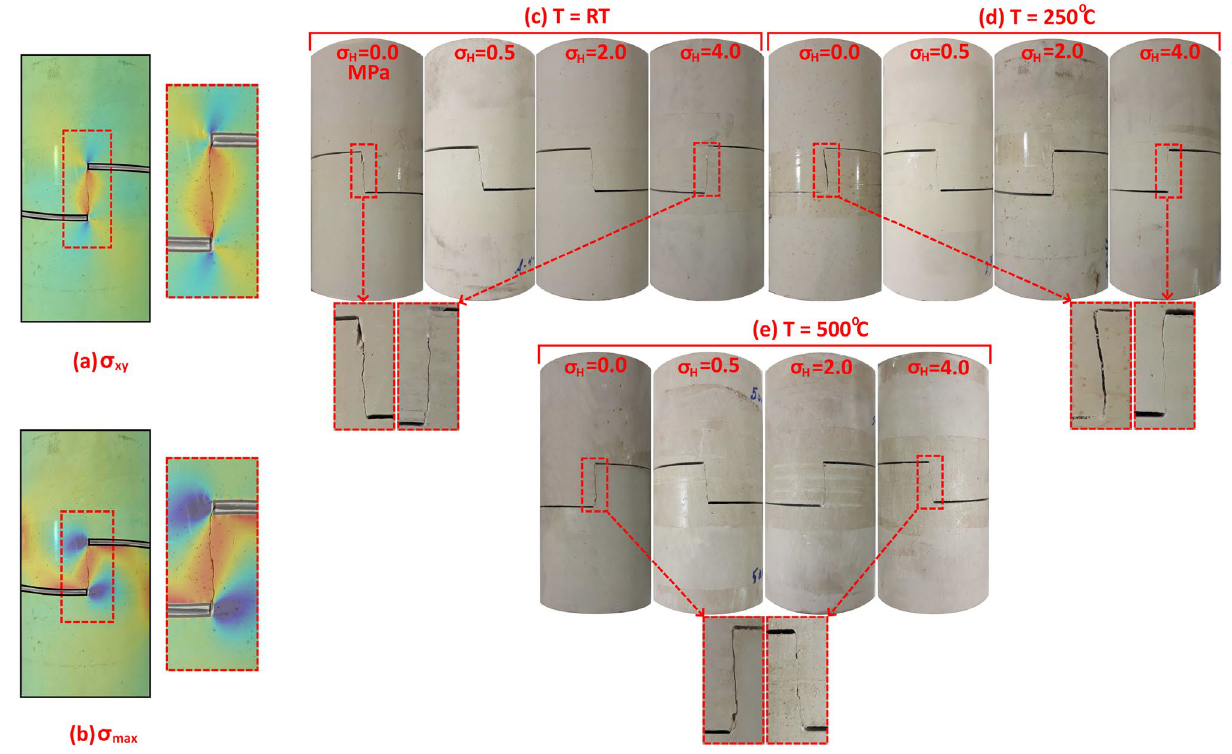
Figure 11. Comparison between numerical results and experimental observations.